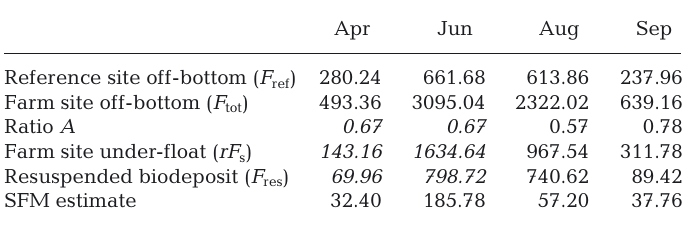
Table 2. Carbon flux estimates (mmol C m −2 d −1 ) from the sediment traps and sediment flux model (SFM, monthly means). Italicized numbers represent estimates based on the average value of Ratio A (fraction of new biodeposi- tion captured in sediment traps) observed in August and September. SFM estimates are the deposition rates of particulate organic carbon, computed using the SFM in comparison to the farm site estimates from under-float and off-bottom traps (see ‘Materials and methods: sediment trap